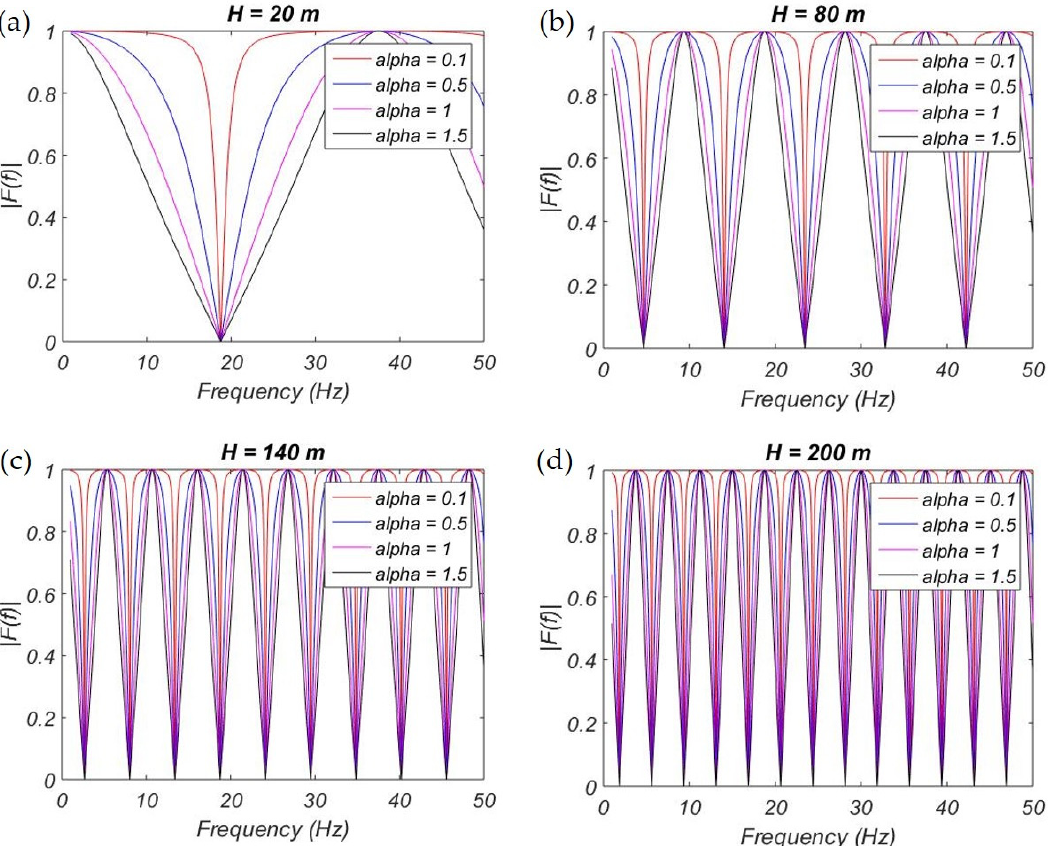
Figure 4. Reduction spectra for vertical component of bottom movements due to the water column of different thicknesses (H) above the site: ( a ) – H = 20 m, ( b ) – H = 80 m, ( c ) – H = 140 m, ( d ) – H = 200 m (alpha—impedance ratio between seawater and seafloor soil).